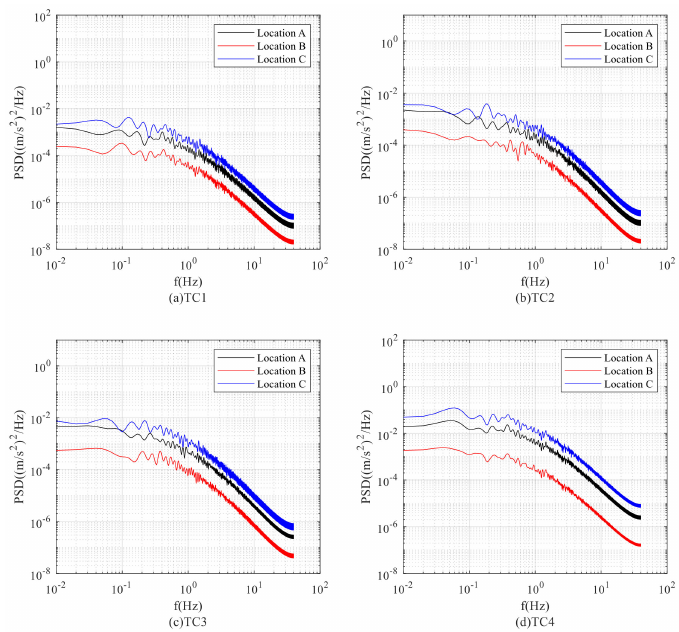
Figure 12. Acceleration spectrum of di ff erent